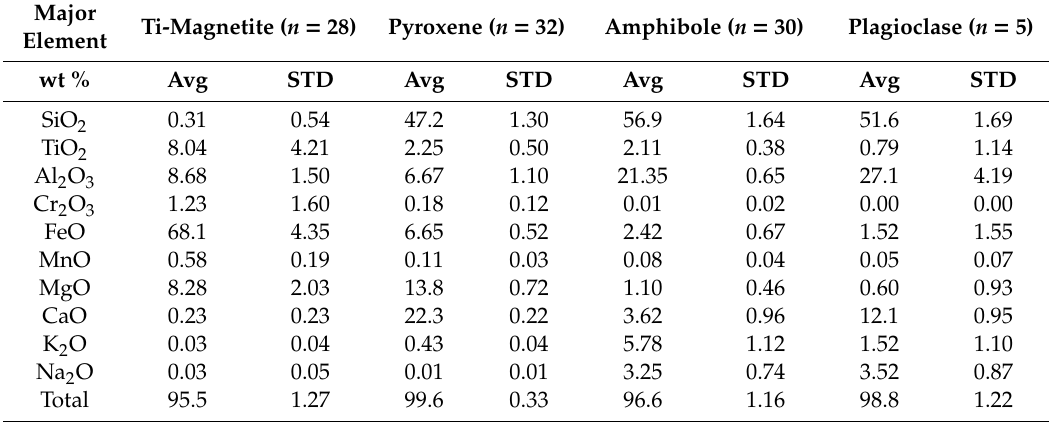
Table 3. Electron-probe microanalyses (EPMA) of representative mineral phases of melt inclusions in the Dokdo and Ulleung volcanic rocks.